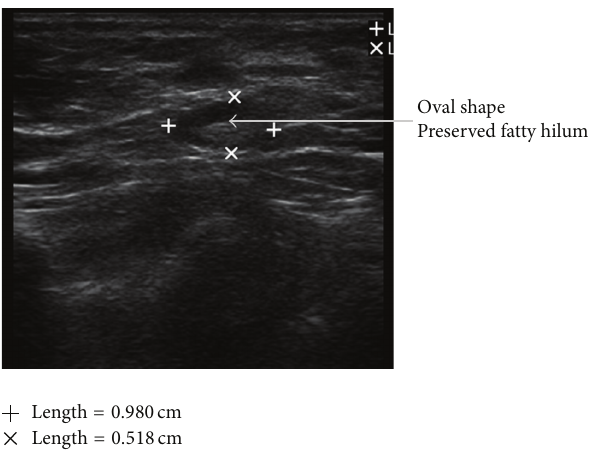
Figure 3: Benign node: oval shape, preserved central hilum.